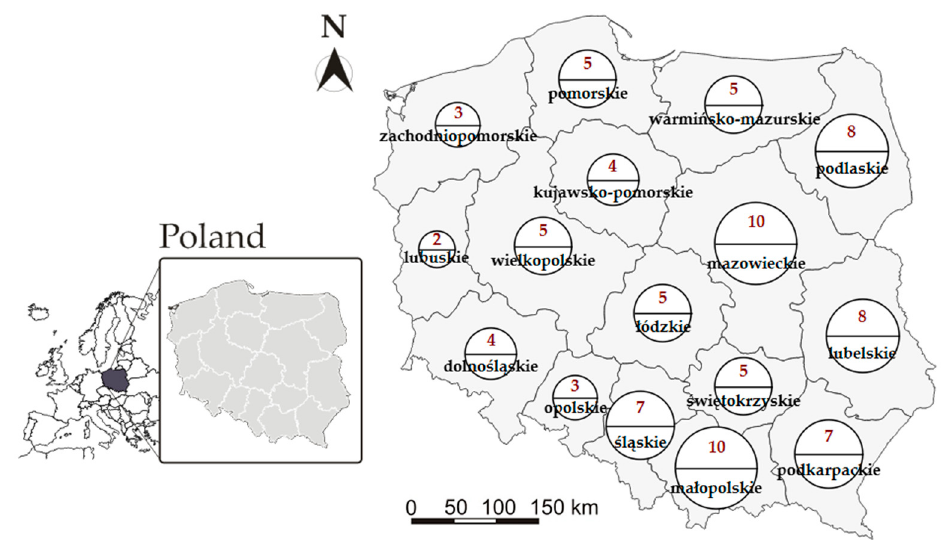
Figure 1. The number of infectious disease hospitals per voivodeship. Source: Original work based on [61].